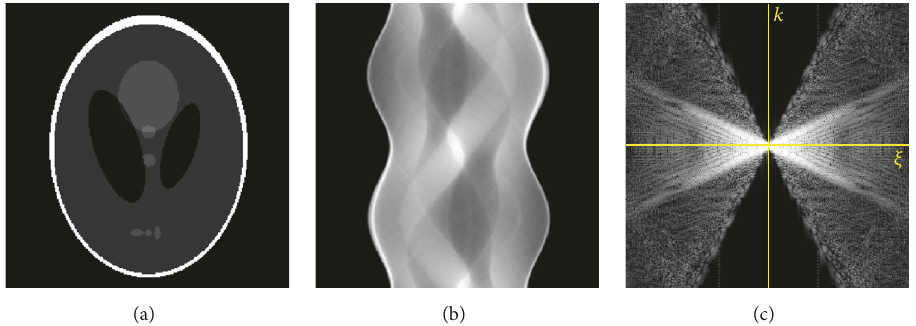
Figure 1: Illustration of zero coefficients in the 2D Fourier transform of a sinogram. (a) Shepp-Logan phantom, (b) the corresponding sinogram, and (c) the 2D Fourier transform of the